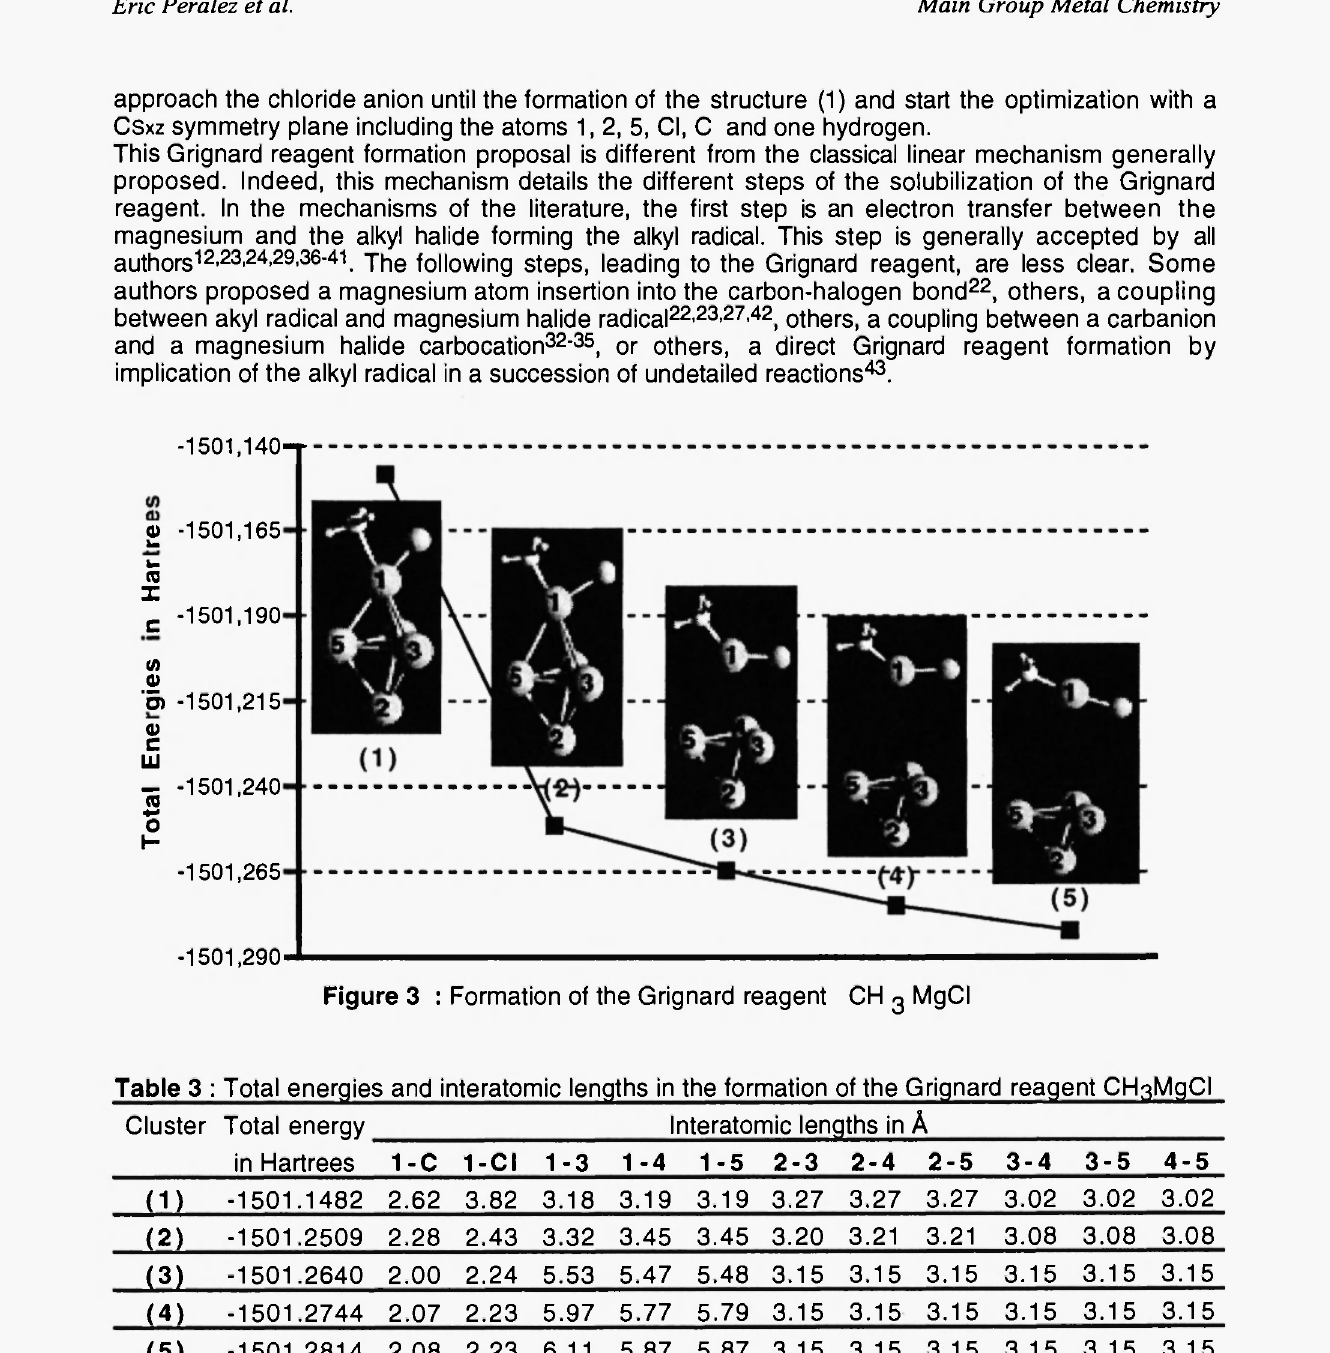
Figure 3 : Formation of the Grignard reagent CH 3 MgCI